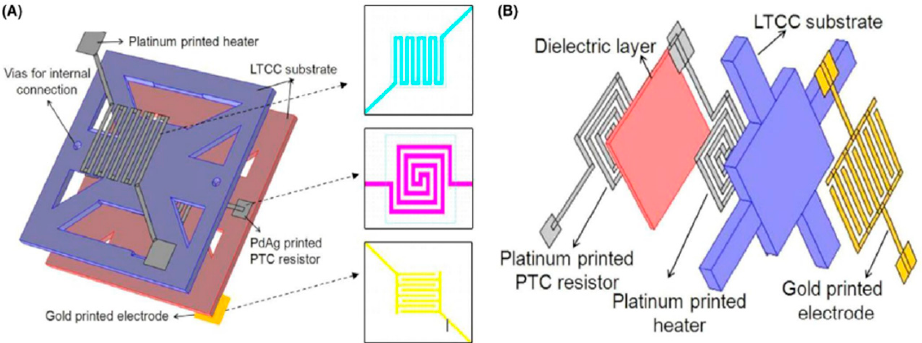
Figure 3. Microhotplates with different LTCC structures: ( A ) PdAg as temperature sensor; ( B ) Pt as temperature sensor [27].